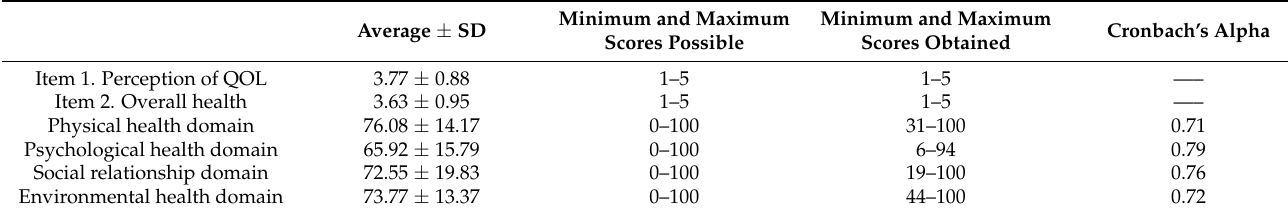
Table 2. Participant scores on the WHOQOL-BREF and reliability for each domain. Average ± SD